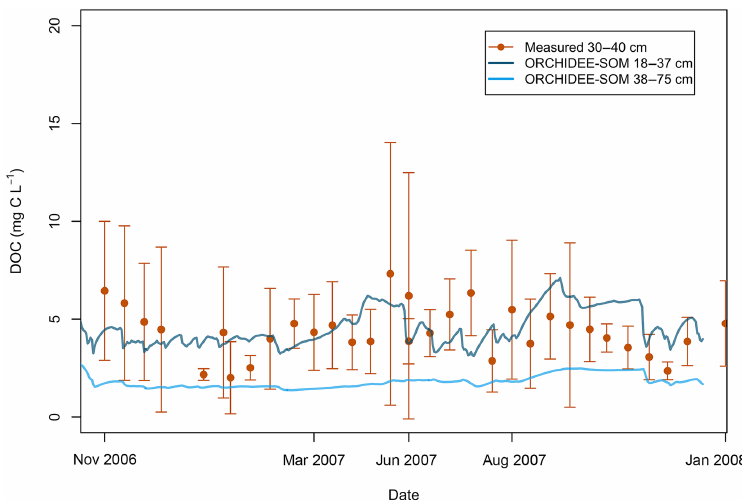
Figure 7. ORCHIDEE-SOM simulated (daily values) and measured DOC dynamics at Carlow cropland measured between 30 and 40cm. Error bars represent the standard deviation of site measurements ( n =